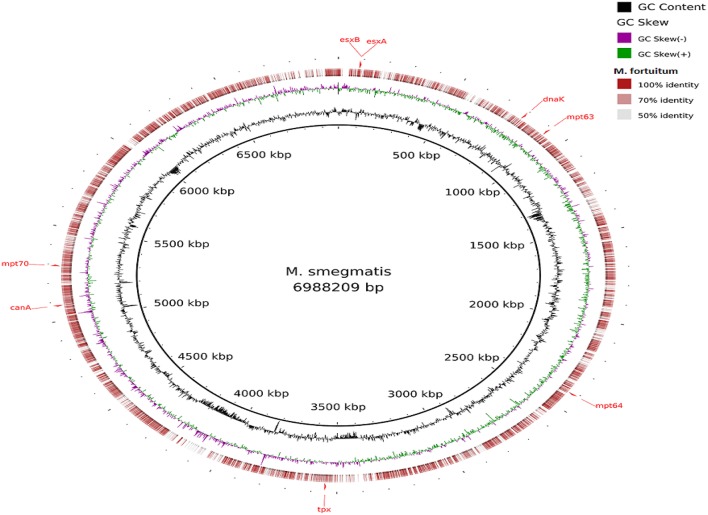
Alignment of M. fortuitum predicted CDS regions to those of M. smegmatis MC2 155 (CP001663.1) using BRIG. Immunogenic proteins of interest identified in M. smegmatis are highlighted in red (esxB: locus tag MSMEG_0065, product hypothetical protein; esxA: locus tagMSMEG_0066, product early secretory antigenic target, 6 kDa; dnaK: locus tag MSMEG_0709, product of chaperone protein DnaK; mpt63: locus tag MSMEG_0828, product immunogenic protein MPT63; mpt64: locus tagMSMEG_2331, product immunogenic protein MPB64/MPT64; mpt70: locus tag MSMEG_5196, product fasciclin domain-containing protein; canA: locus tag MSMEG_4985, product carbonic anhydrase; tpx: locus tagMSMEG_3479, product thiol peroxidase).